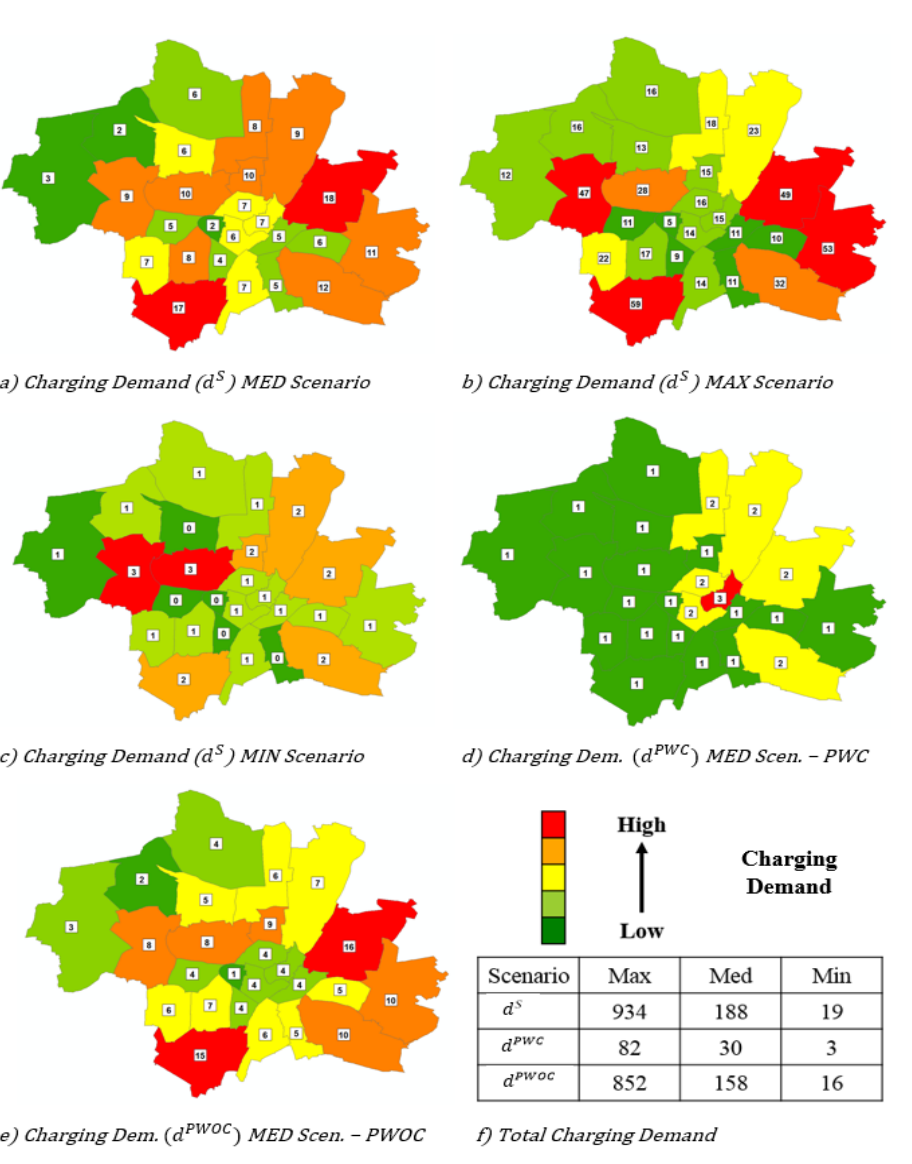
Figure 5. Results of charging demand estimation - Number of expected charging events. Shown is the study